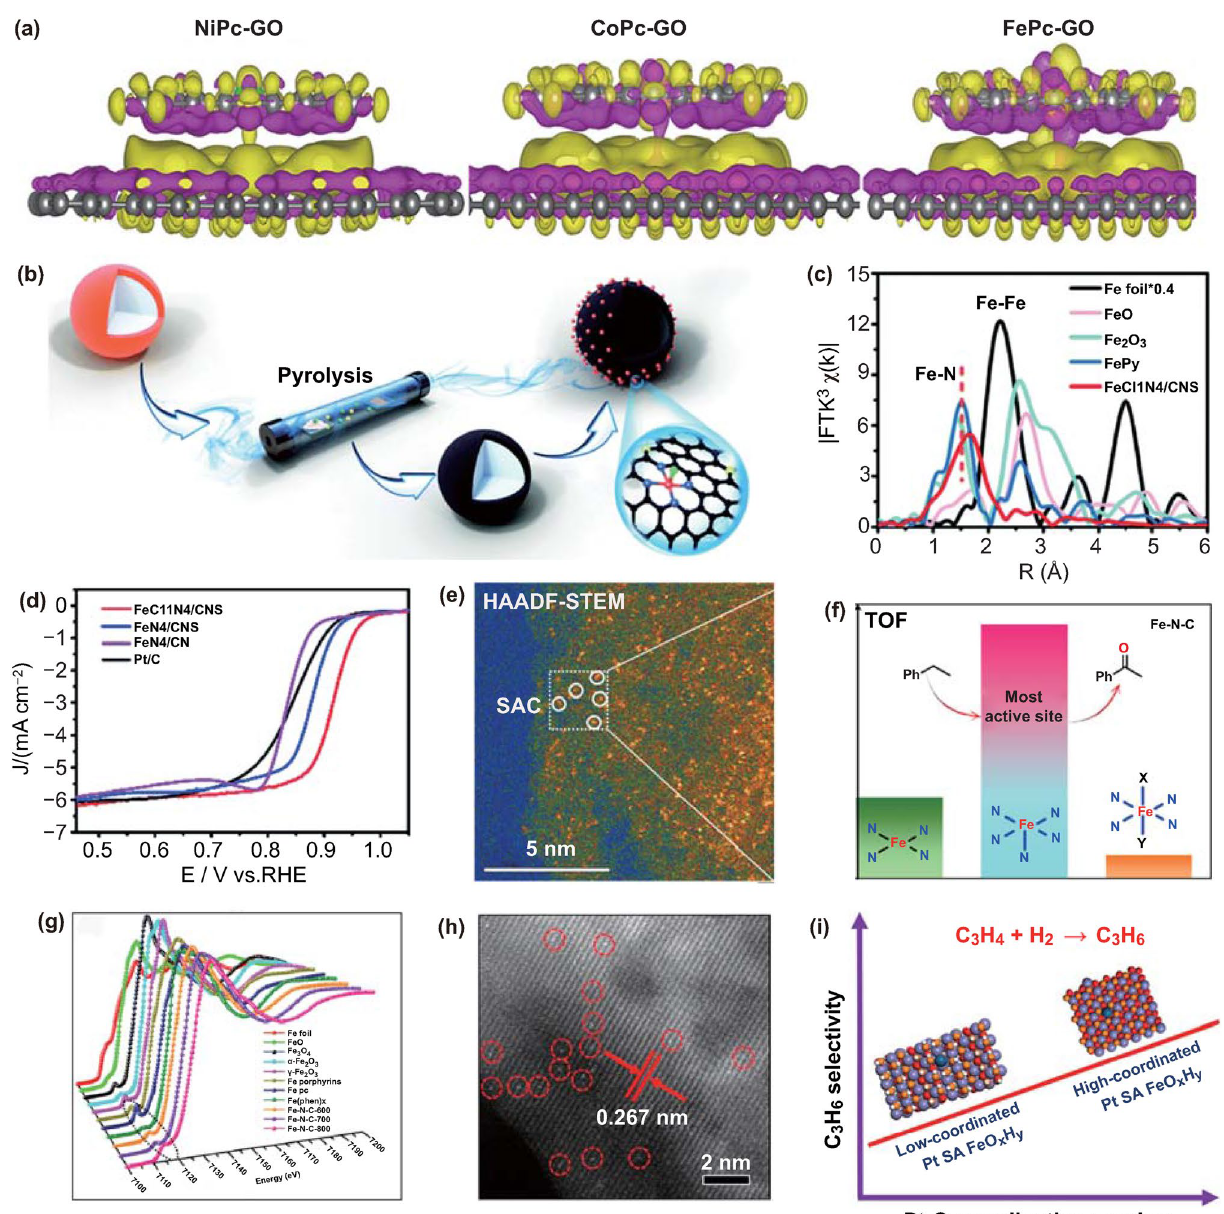
Fig. 3 a DFT simulations of the synergistic effect between MPcs (M = Ni, Co, Fe) and GO. Isosurface plots of charge redistribution for NiPc- GO, CoPc-GO and FePc-GO. Yellow or violet color represents the accumulation or depletion of electrons, respectively. Reproduced from Ref. [70] with permission. Copyright 2020 American Chemical Society. b Schematic illustration of the synthesis of FeCl 1 N 4 /CNS. c Fourier trans- form (FT) at the Fe K-edge of the FeCl 1 N 4 /CNS, FePy, FeO, Fe 2 O 3 sample and Fe foil. d ORR polarization curves in O 2 -saturated 0.1 M KOH. b–d Reproduced from Ref. [72] with permission. Copyright 2018 The Royal Society of Chemistry. e HAADF-STEM images of Fe–N–C. f Fe III N 5 affords the highest turnover frequency for the selective oxidation of the C–H bond. g The normalized XANES spectra at the Fe K-edge of different samples. The dotted ellipse shows the pre-edge peak at 7117 eV. e–g Reproduced from Ref. [73] with permission. Copyright 2017 American Chemical Society. h High-resolution AC-STEM image of isolated Pt atoms. i The propylene selectivity increases as the coordination number of Pt–O increases. h‑i Reproduced from Ref. [76] with permission. Copyright 2020 American Chemical